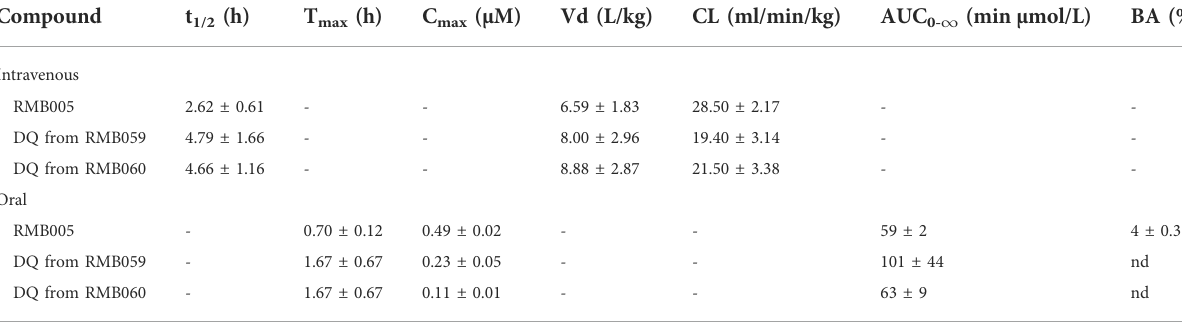
TABLE 4 Summary of in vivo pharmacokinetic (PK) parameters after intravenous 4) and oral ( po ) administration in mice.